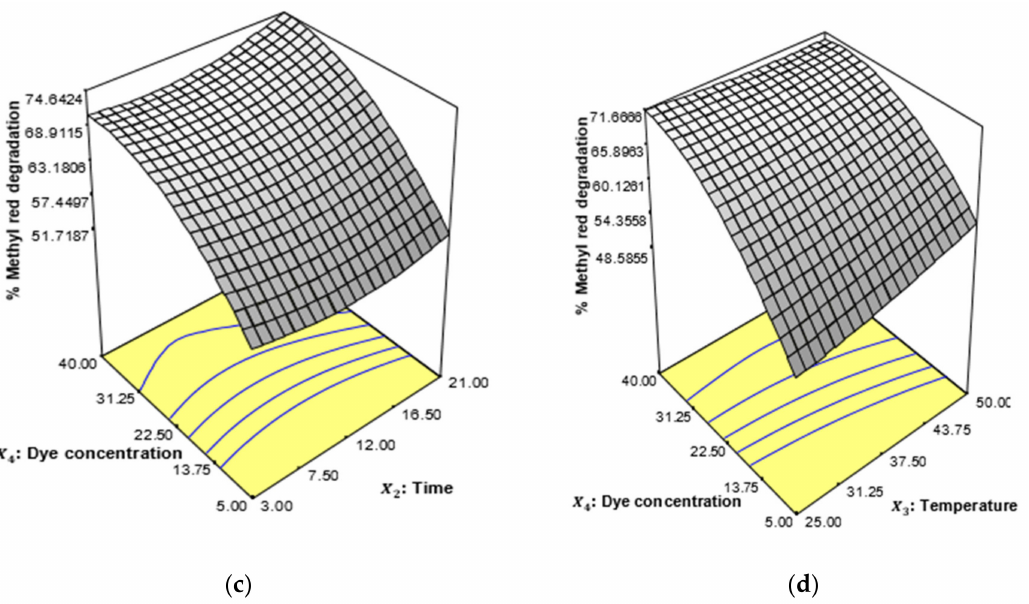
Figure 11. Response surface plot for the interaction of ( a ) pH and incubation time ( b ) pH and temperature ( c ) incubation time and dye concentration ( d ) temperature and dye concentration for the biodegradation of methyl red using P. aeruginosa